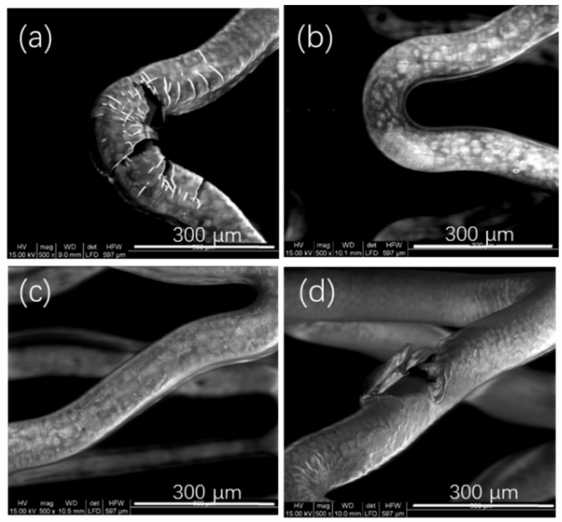
Figure 3. Morphologies of coating surfaces made with different drug polymer ratios of P34HB. ( a ) 1:1; ( b ) 1:2; ( c ) 1:10; ( d ) 1:12.